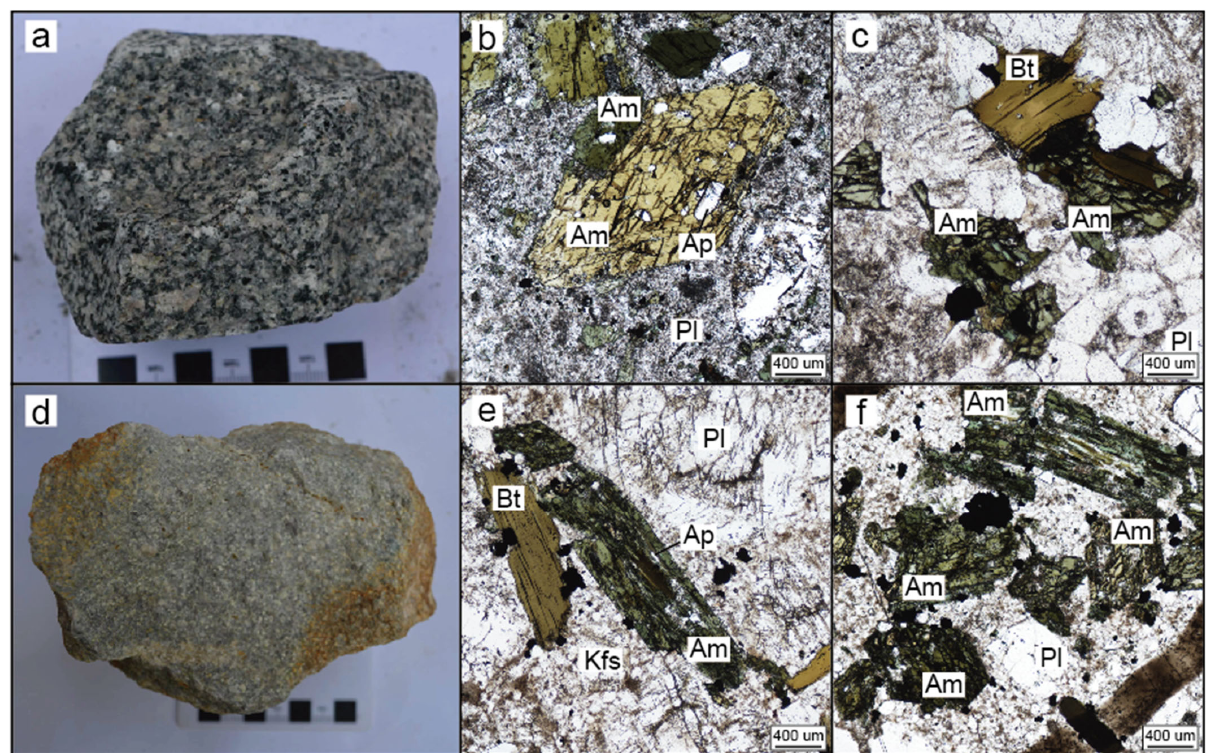
Figure 2. Photos of the quar tz syenite porphyries from Tongchang–Chang’anchong porphyry de- posit: ( a ) hand specimen of Tongchang quar tz syenite porphyry; ( b , c ) photomicrographs of deposit: ( a ) hand specimen of Tongchang quartz syenite porphyry; ( b , c ) photomicrographs of Tongchang quar tz syenite porphyry; ( d ) hand specimen of Chang’anchong quar tz syenite porphyry; Tongchang quartz syenite porphyry; ( d ) hand specimen of Chang’anchong quartz syenite porphyry; ( e , f ) photomicrographs of Chang’anchong quar tz syenite porphyry. Am, amphibole; Bt, biotite; Kfs, ( e , f ) photomicrographs of Chang’anchong quartz syenite porphyry. Am, amphibole; Bt, biotite; Kfs, potassic feldspar; Pl, plagioclase; Ap, apatite. potassic feldspar; Pl, plagioclase; Ap,